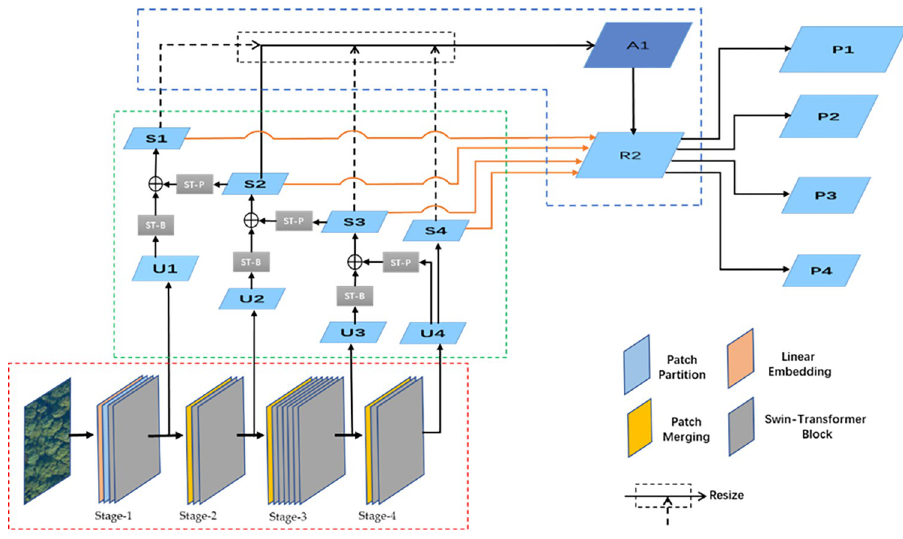
Fig 6. Structure of the proposed